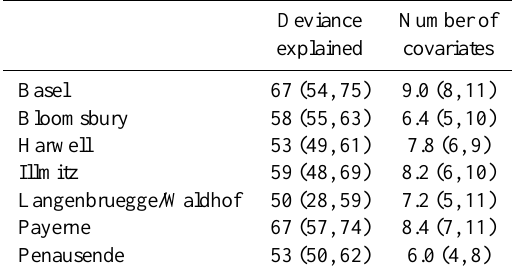
Table 4. Deviance explained (%) and number of covariates aver- aged over all seasonal and yearly values for each station. Numbers in parentheses indicate the minimum and the